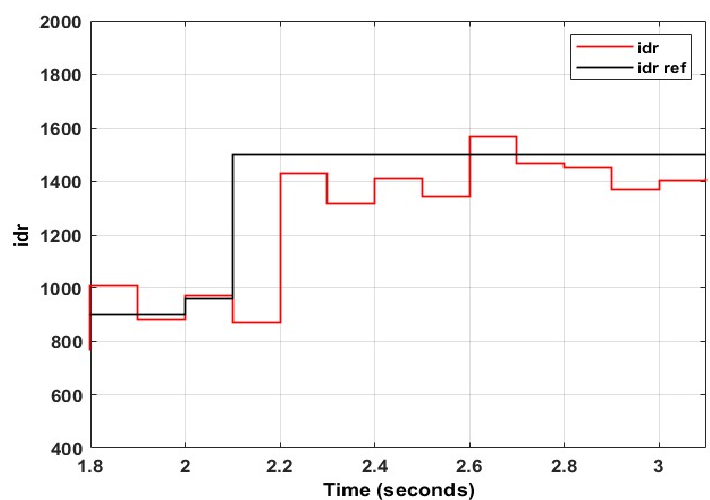
Figure 24. Rotor direct axis current average using PI at 70% dip.